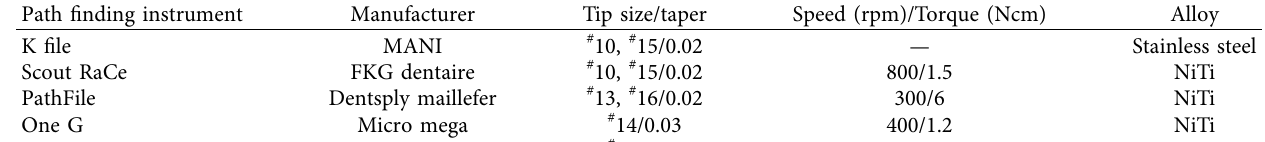
Table 1: Main characteristics of path finding instruments used in the present study.